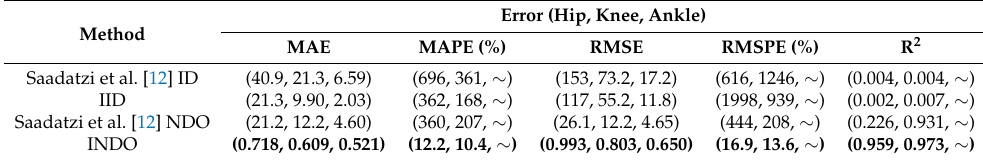
Figure 10. Comparison of ( a ) IID and Saadatzi et al. [12] ID method, and ( b ) INDO and Saadatzi et al. [12] NDO method, during a leg press exercise with SNR = 40dB and 20% BSIPs uncertainties. Table 4. Human–robot interaction torque estimation methods performance indices during a leg press exercise with SNR = 40dB and 20% BSIPs uncertainties. Bold numbers highlight the best metric